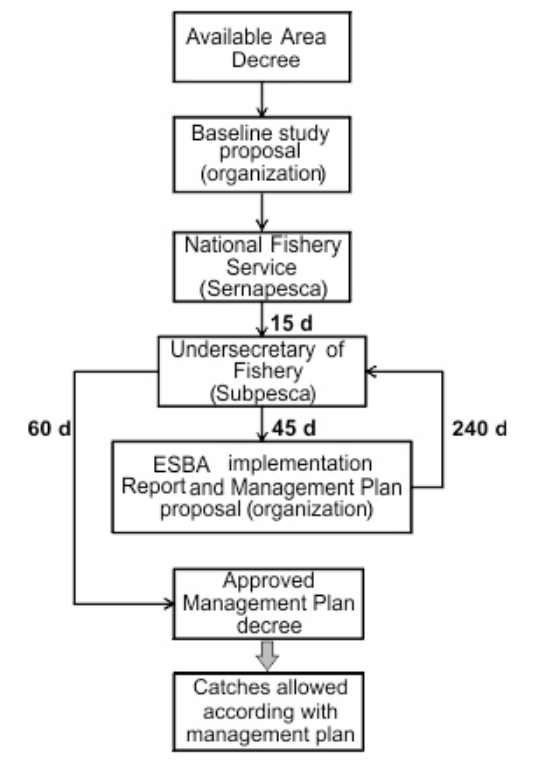
Fig. 3 . Flow diagram of AMERB (Management Areas for the Exploitation of Benthic Resources) application process, bold numbers indicate the suggested time for each step (d =